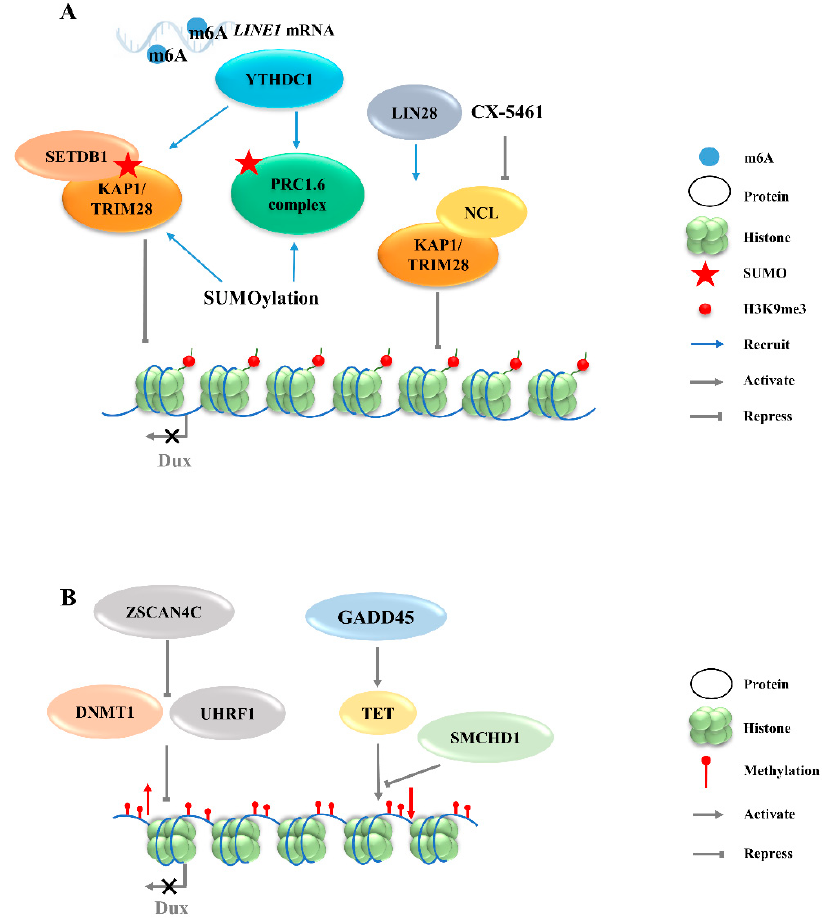
Figure 2. Regulation of Dux expression by epigenetic modifications. ( A ): Dux expression regulated by histone modifications transcription. The activation of H3K9me3 regulators caused by YTHDC1 and LIN28 will enhance the H3K9me3 levels and silence Dux expression finally. ( B ): Dux expression regulated by DNA modifications. DNA methylations caused by DNMT1/UHRF1 and TET repress Dux expression. LINE1, long interspersed nuclear element-1; SETDB1, SET domain bifurcated histone lysine methyltransferase 1; KAP1, KRAP-associated transcriptional repressor; TRIM28, tripartite motif-containing protein 28; PRC1.6, polycomb-repressive complexes 1.6; NCL, nucleolin; ZSCAN4C, SCAN domain containing 4C; DNMT1, DNA methyltransferase 1; UHRF1, ubiquitin like with PHD and ring finger domains 1; GADD45, growth arrest and DNA damage 45; TET, ten-eleven translocation; SMCHD1, structural maintenance of chromosomes flexible hinge domain containing 1.